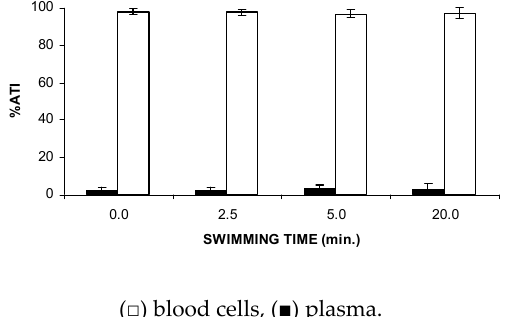
Figure 2. Effect of the forced swimming (FS) on the distribution of 99m Tc between the cellular and plasma compartments. Wistar rats were submitted to FS, blood samples were withdrawn, and the labeling of blood constituents with 99m Tc procedure was carried out. Blood cells and plasma were separated by centrifugation. The radioactivity in blood cells and plasma was measured and the percentage of 99m Tc incorporated (%ATI) was calculated.